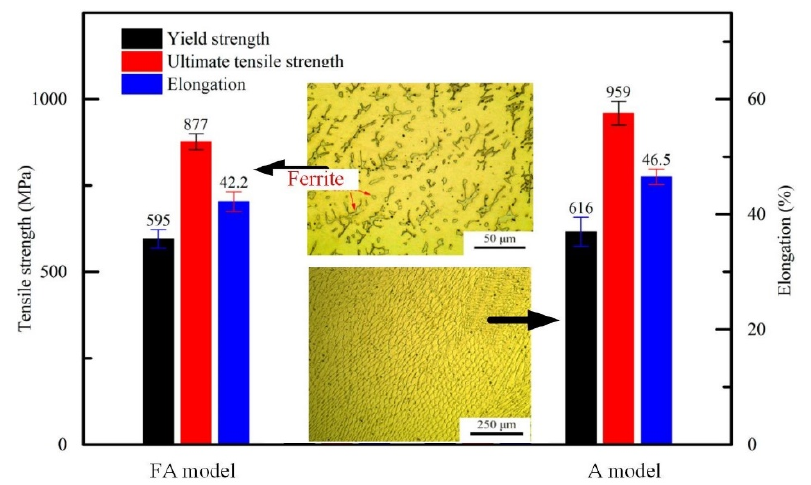
Figure 12. Effect of microstructures on mechanical properties of the HNS structure. Reproduced with permission from ref. [28]. Copyright 2021, Elsevier.